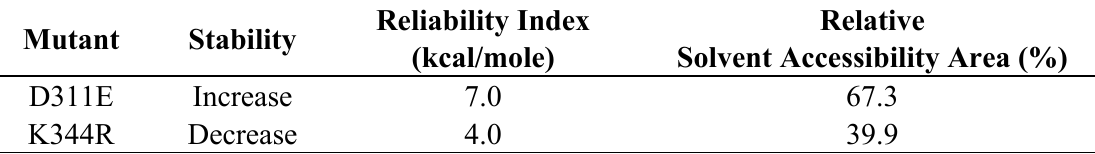
Table 1. Summary of prediction energy, based on single point of